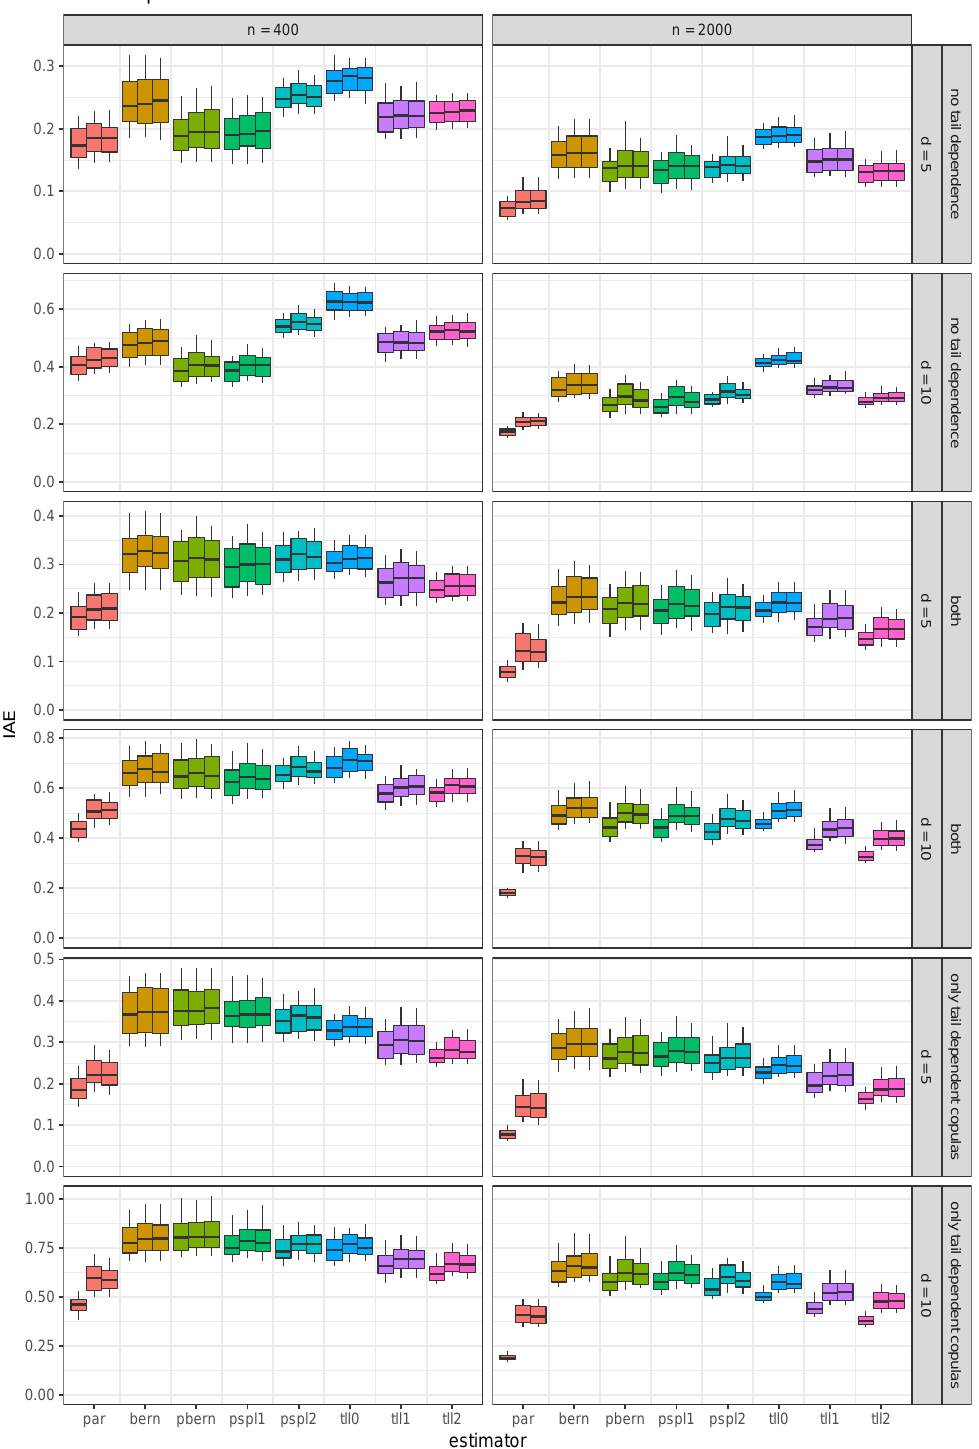
Figure 3: weak dependence: the box plots show the IAE achieved by each estimation method. Results are split by sample size, dimension, and type of dependence. Per estimator there are three boxes, corresponding to estimation under known structure, selection by Kendall’s τ , and selection by cAIC (from left to